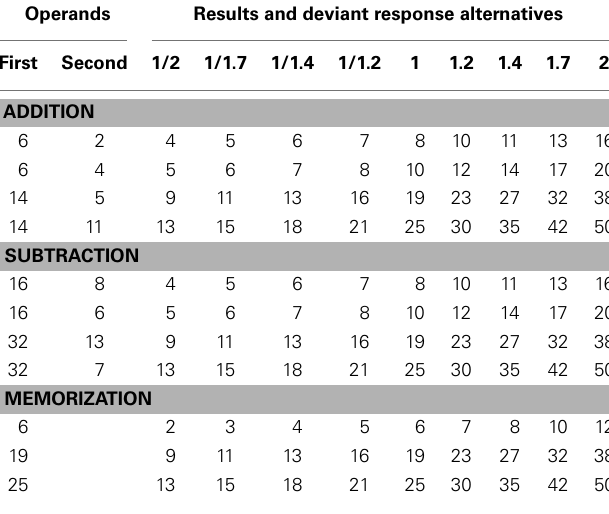
Table 1 |Arithmetic problems presented in the non-symbolic calculation experiment and their correct and deviant